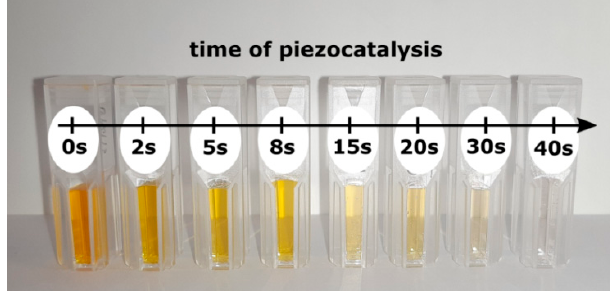
Figure 3. Photograph of the methyl orange (MO) aqueous solutions samples after different times of ultrasonic irradiation. Piezocatalysis was performed using VCX-750 ultrasonic reactor (Sonics & Materials Inc., Newtown, CT, USA) with ultrasound frequency f = 20 kHz and power P = 750 W.